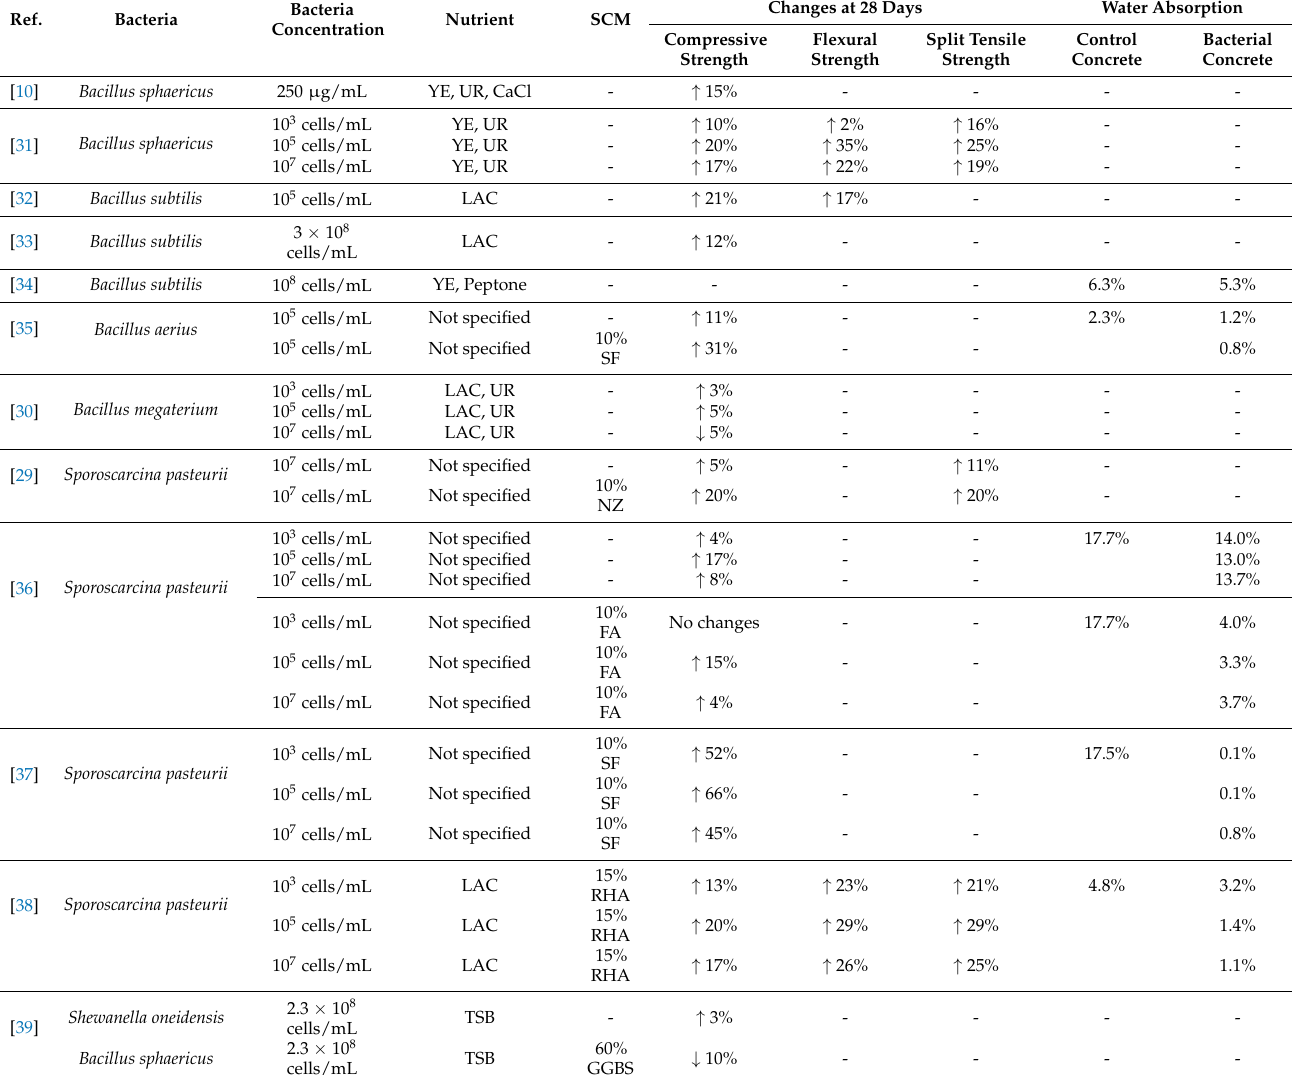
Table 4. Comparison of various bacteria applications in normal strength concrete and their effects on the mechanical and durability